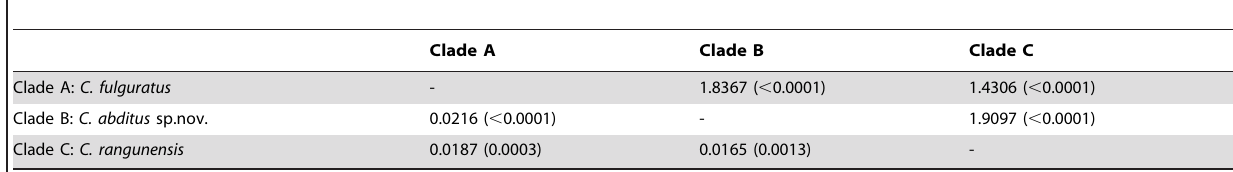
Table 6. Mahalanobis distances and Procrustes distances of three Cyclophorus fulguratus clades derived from canonical variate analysis (CVA) of the shell shape with p-values (shown in parenthesis) calculated by 10,000 random permutations per test to determine statistical significance of differences between pairs of clades.